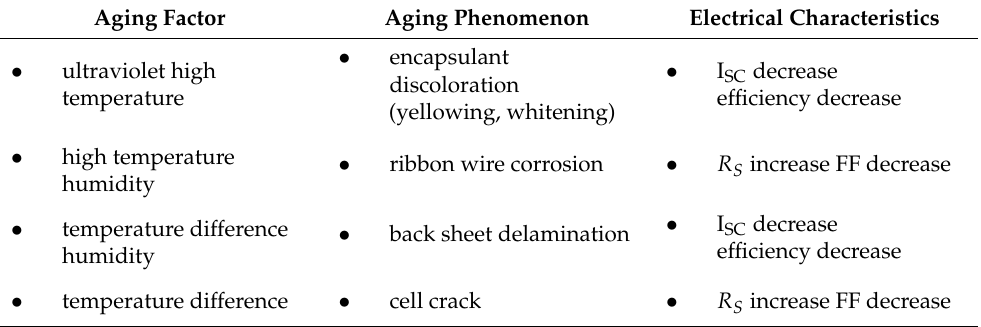
Table 1. Aging characteristics of a PV module.